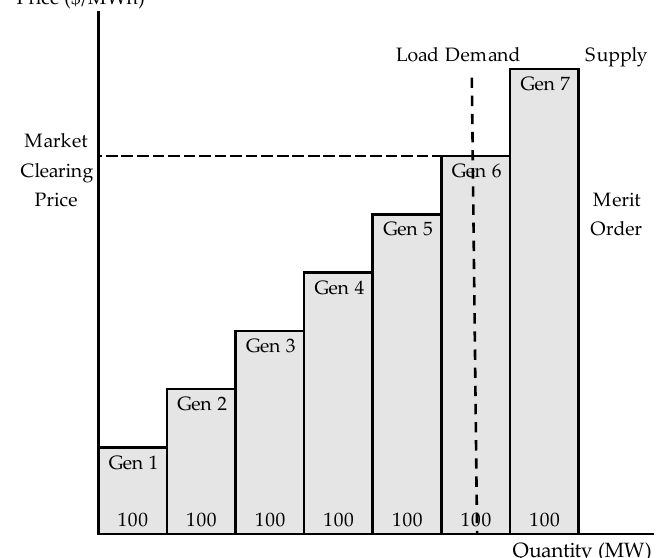
Figure 4. Least-cost dispatch model [43].